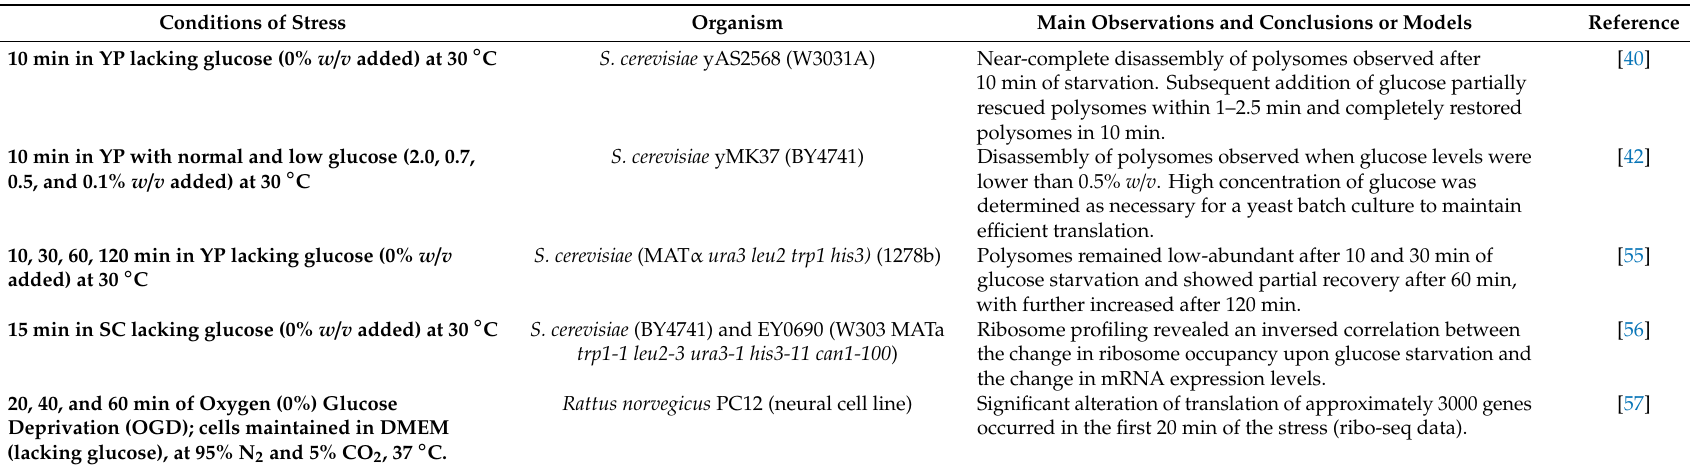
Table 1. Overview of principal studies on the regulation of translation initiation during glucose